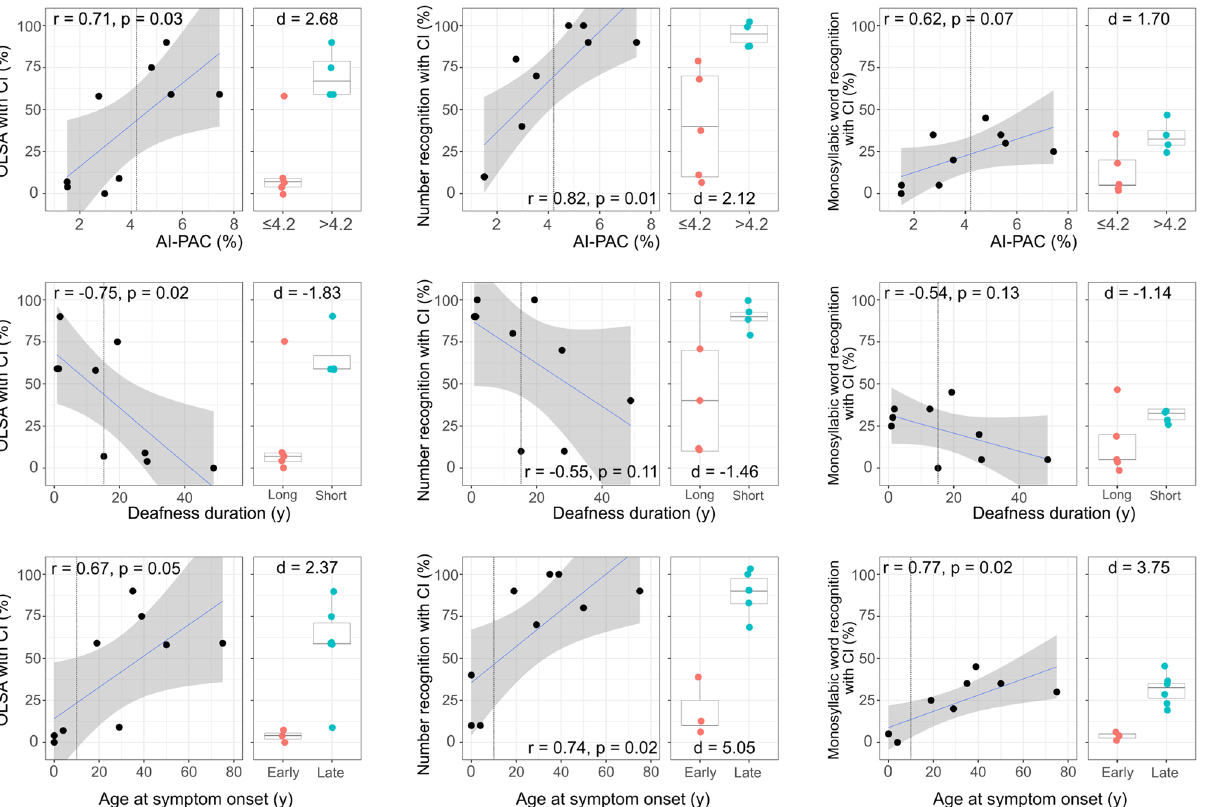
Figure 1. Associations between asymmetry index (AI) of the primary auditory cortex (PAC), deafness duration and age at symptom onset with the hearing tests: sentence recognition (OLSA), number recognition and monosyllabic word recognition with cochlear implant (CI) six-month post implantation. Each dot represents individual data. Dashed line shows corresponding cutoffs. Linear regression analysis displayed as regression line (blue) and 95% confidence interval (grey area). r Pearson correlation coefficient, d Cohen’s